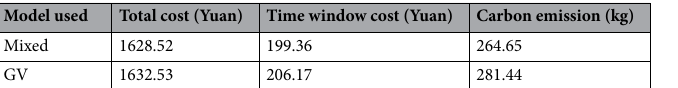
Table 3. The effect of various vehicles.